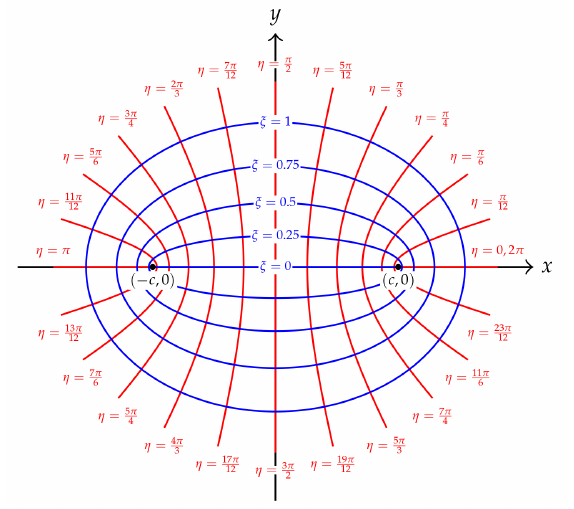
Figure 2. Elliptic coordinate system ( ξ , η ) : the blue line represents the coordinate ξ and the red line represents the coordinate η